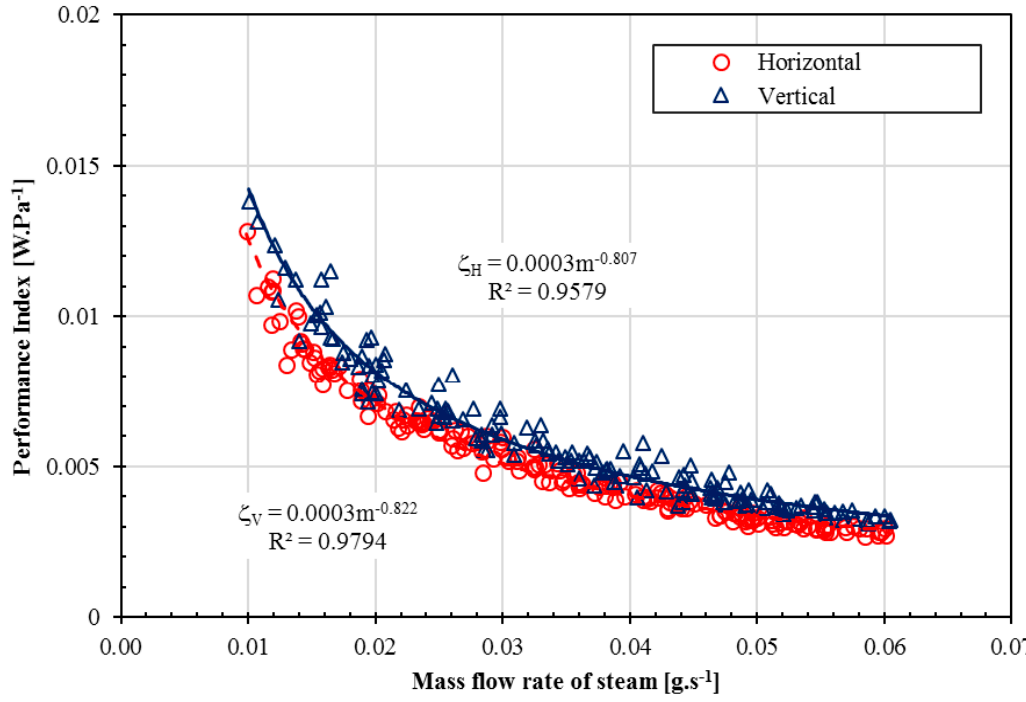
Figure 9. Comparison of the performance index in the cases of horizontal and vertical microchannels.